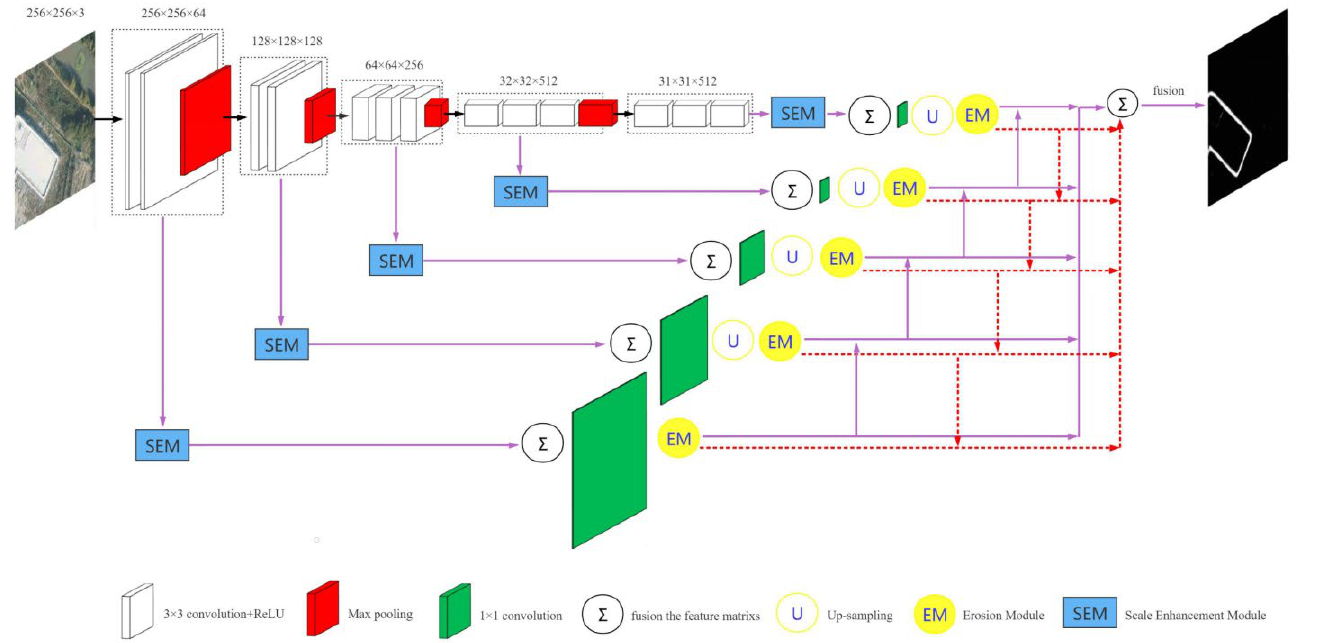
Figure 4. Overview of our proposed ME-Net architecture.